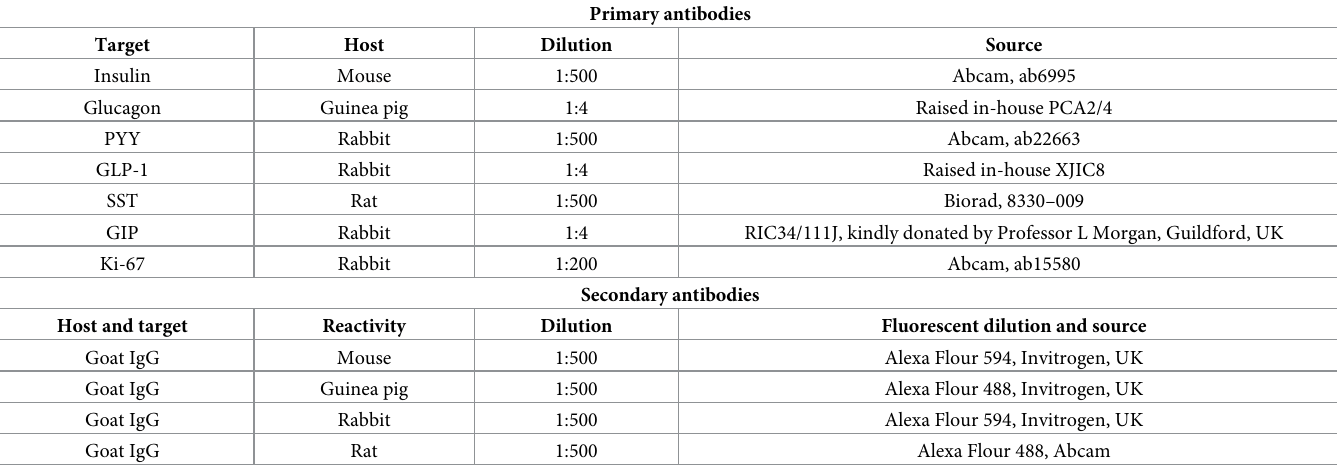
Table 1. Target, host and source of primary and secondary antibodies employed for immunofluorescent islet histology